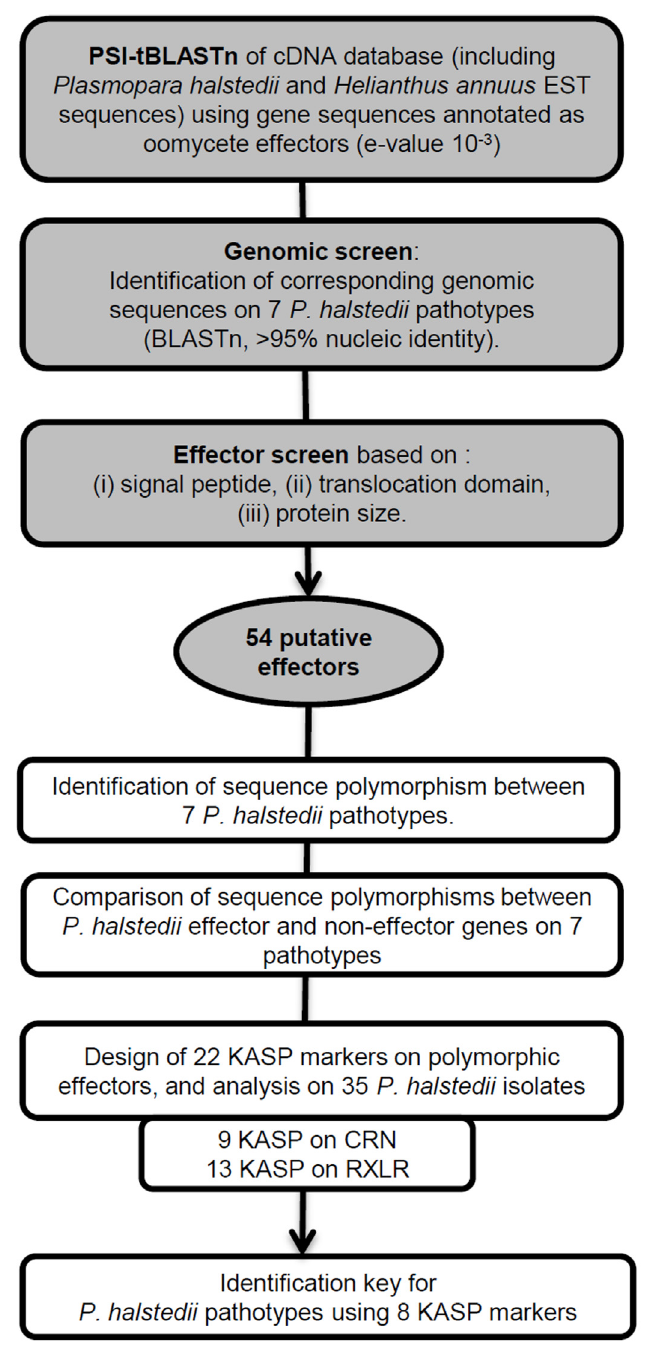
Fig 1. Workflow of the study. In grey, the procedure used to select candidate effector genes. Transcriptomic data from sunflower leaves infected by Pl . halstedii or isolated zoospores were analyzed by PSI-tBLASTn using the annotated sequences that were available in NCBI in March 2010 as models for RXLR and CRN effectors. In white, the procedure used to build the Pl . halstedii pathotype determination key. Identification of effector polymorphism was done by comparisons between genomic sequences obtained in 7 representative pathogen pathotypes (100, 300, 304, 334, 700, 703 and 710). Among the 22 KBioscience Competitive Allele Specific PCR (KASP) markers, eight were used in a determination key to discriminate Pl . halstedii pathotypes.